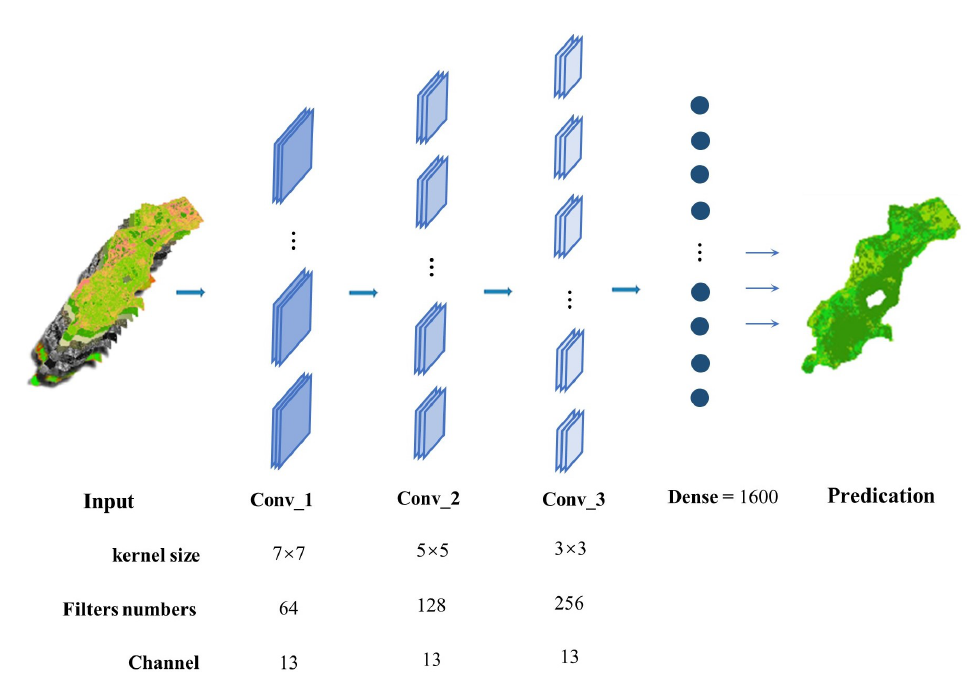
Figure 5. CNN frame